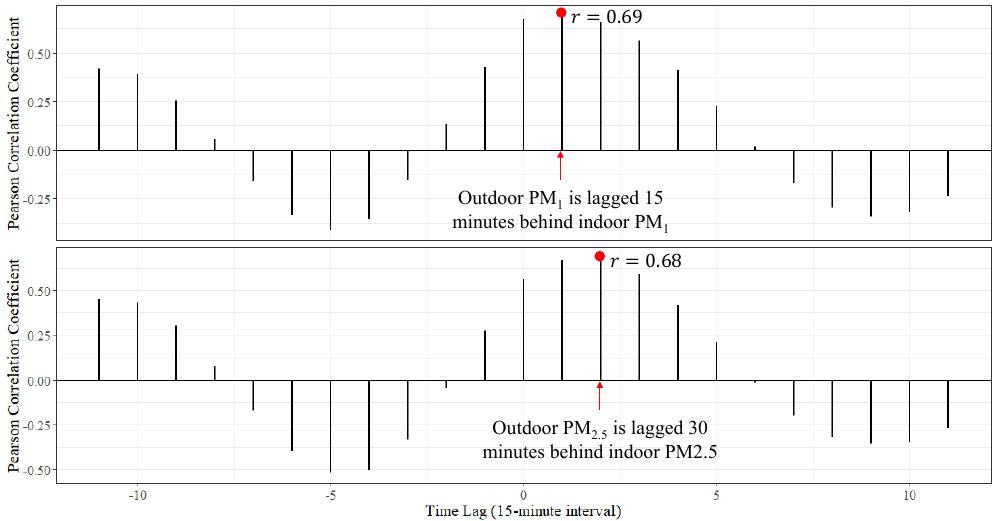
Figure 9. Cross-correlation of indoor and outdoor PM 1 and PM 2.5